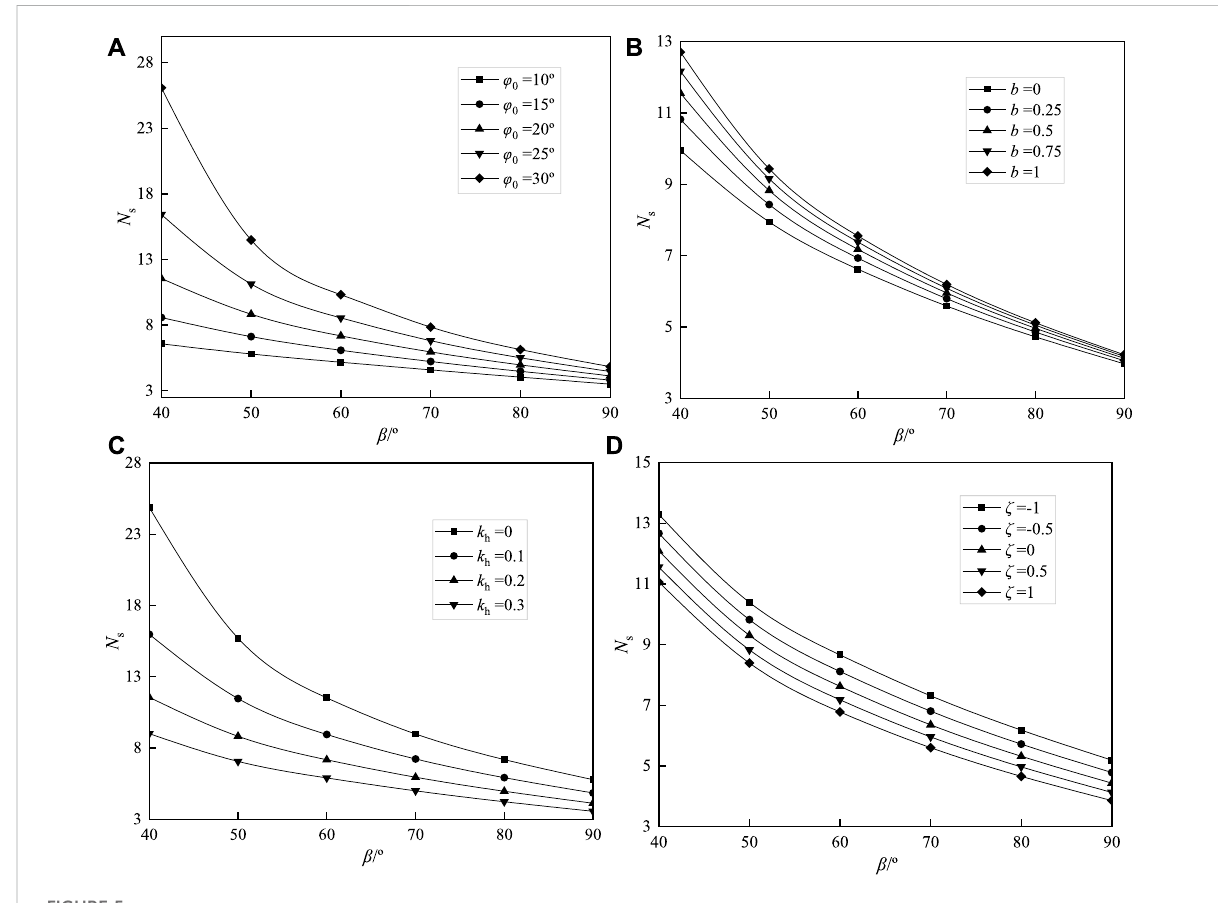
FIGURE 5 Effect of slope angle on stability factor: (A) k h =0.2, b =0.5, ζ =0.5; (B) k h =0.2, φ 0 =20 ° , ζ =0.5; (C) φ 0 =20 ° , b =0.5, ζ =0.5; (D) φ 0 =20 ° , b =0.5, k h =0.2.